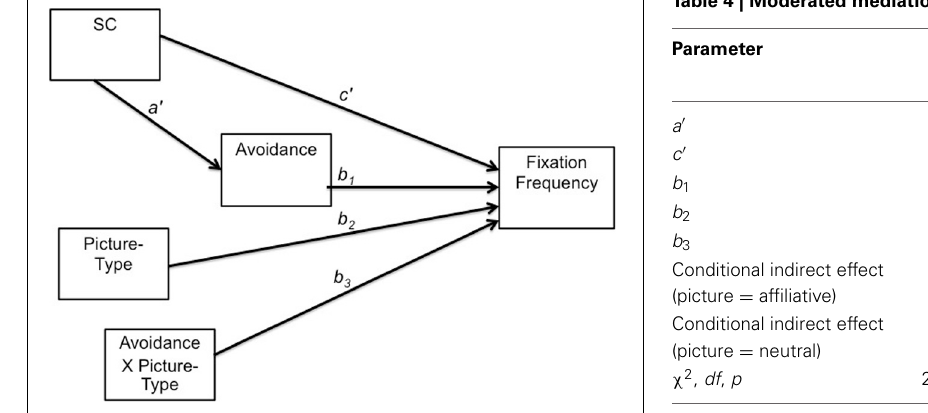
FIGURE 4 | Moderated mediation model. See text for details. Estimated directed paths are labeled, where c ’ represents the direct effect of SC on fixation frequency, a 1 the effect of SC on the mediator (avoidance), b 1 the mediated effect of SC on fixation frequency, b 2 the effect of the moderator (picture-type) on fixation frequency, and b 3 the interaction of the mediated effect and picture-type.